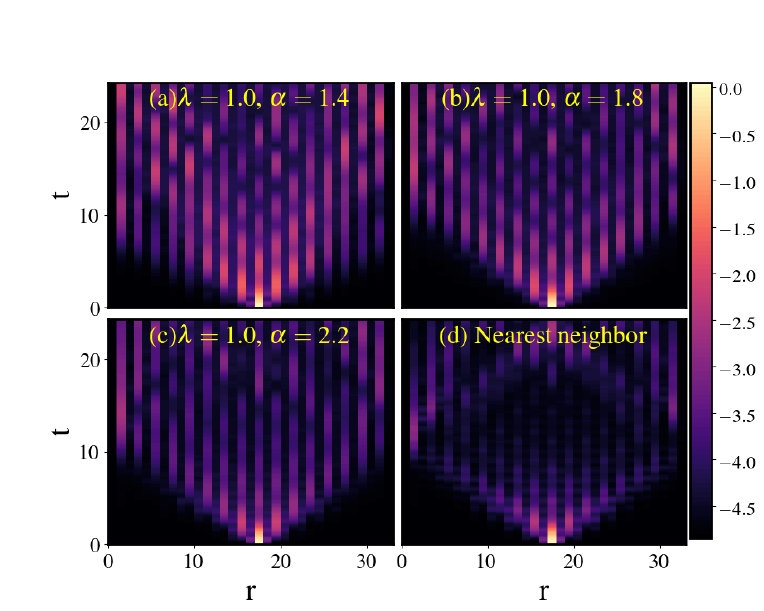
Figure 11: Magnon density 〈 N ↑ ( r , t ) N ↑ ( r + 1, t ) N ↑ ( r + 2, t ) 〉 for λ = 1 and different values of α , obtained using Villain’s approximation including three spinons and one